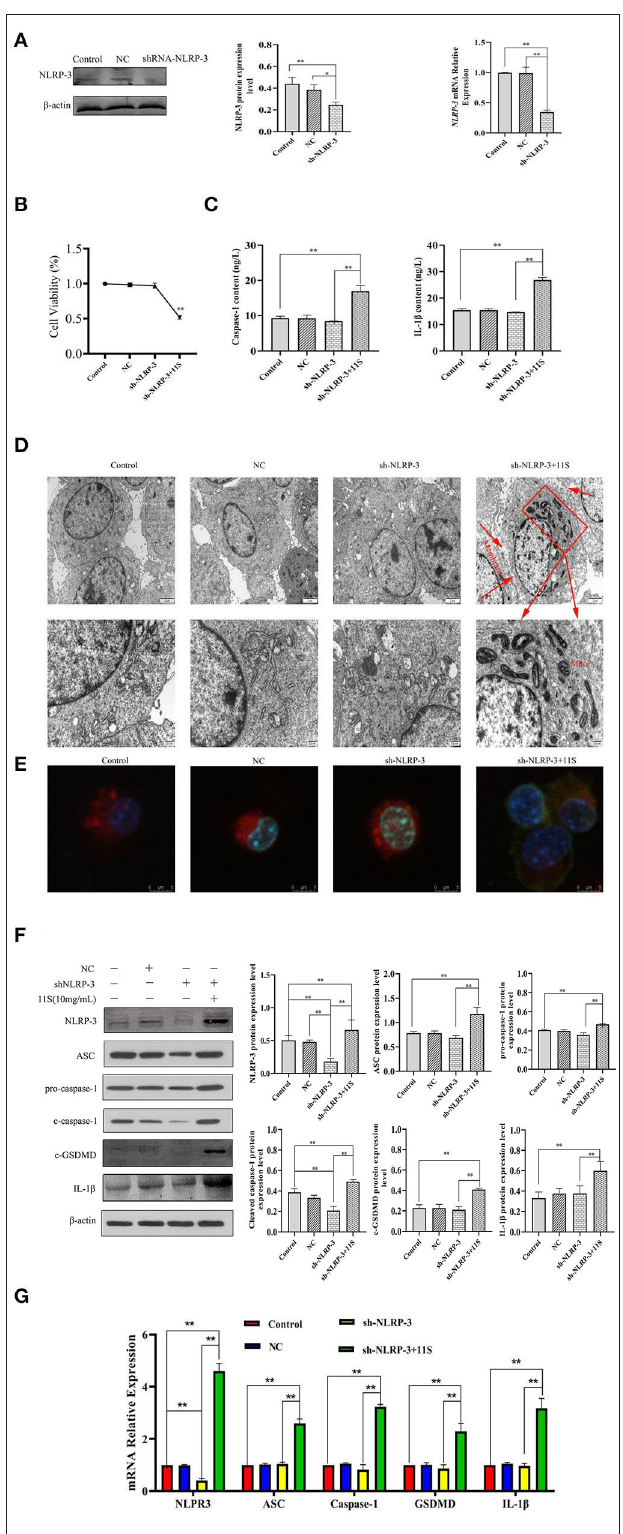
FIGURE 4 | 11S glycinin induced pyroptosis by up-regulating the silenced NLRP-3 gene in IPEC-J2 cells. IPEC-J2 cells were transfected with designed